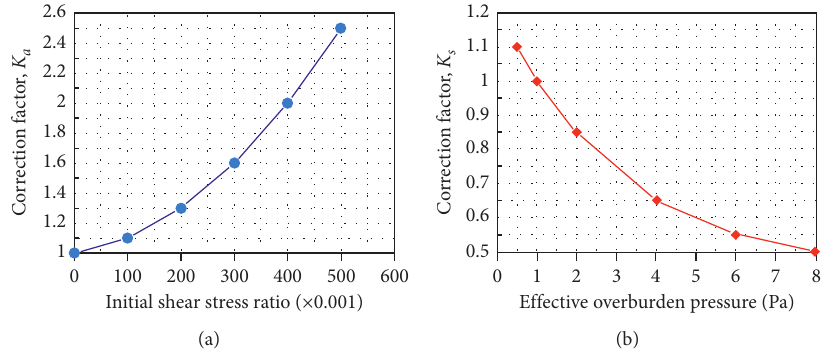
Figure 2: Correction curves for K